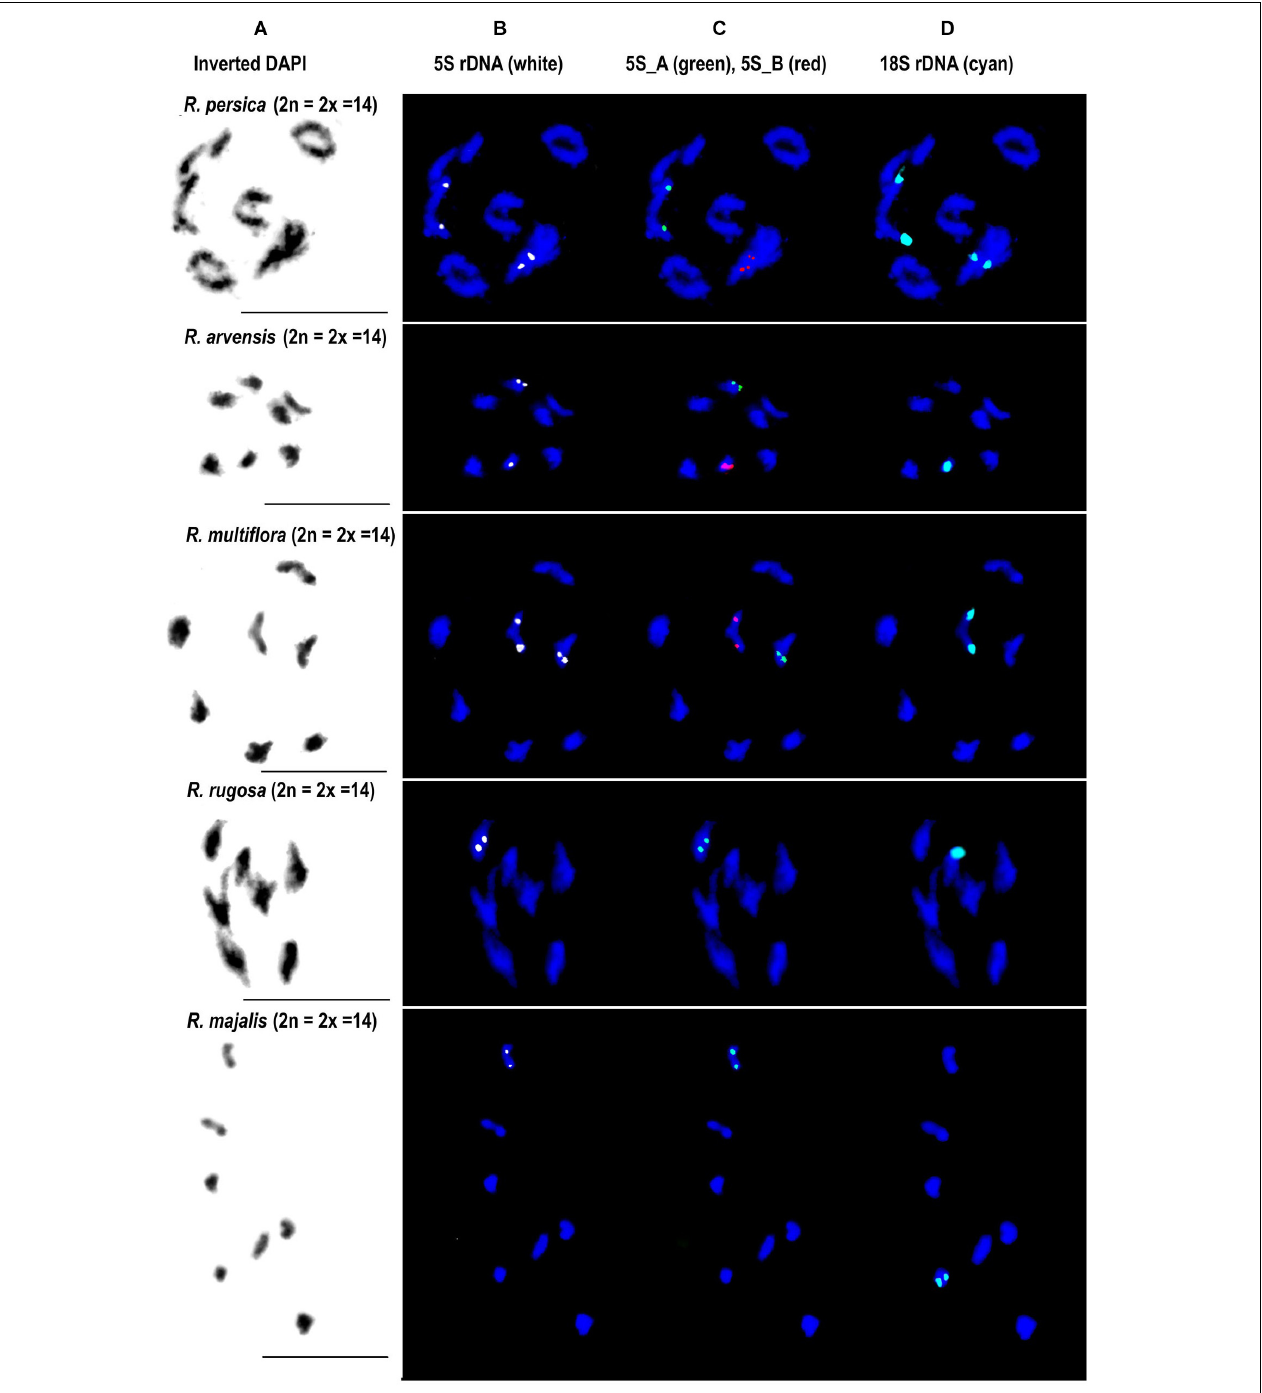
FIGURE 5 | FISH analysis of 5S rDNA in diploid species. Diakinesis of meiotic phase I shown in R. persica (subgenera Hulthemia ), R. arvensis and R. multiflora (section Synstylae ), R. rugosa and R. majalis (section Rosa ). In each species, the same metaphase was hybridized with the 5S genic (B) , 5S intergenic (C) , and 18S rDNA (D) probes. (A) DAPI staining (gray scale, inverted) of chromatin. Scale bar: 10 µ m.